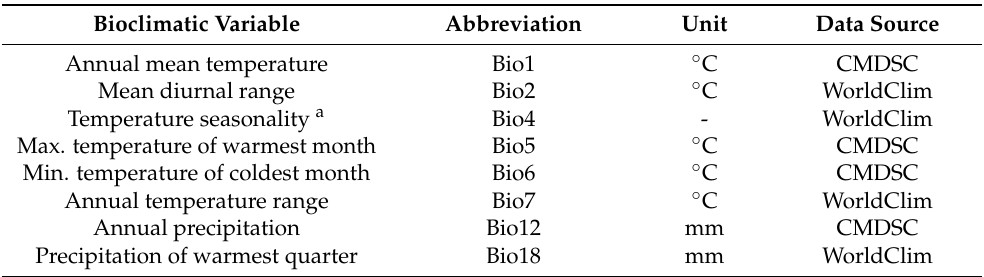
Table 1. Eight of the original 19 bioclimatic variables were selected for modeling the suitable habitats of J. mimosifolia in